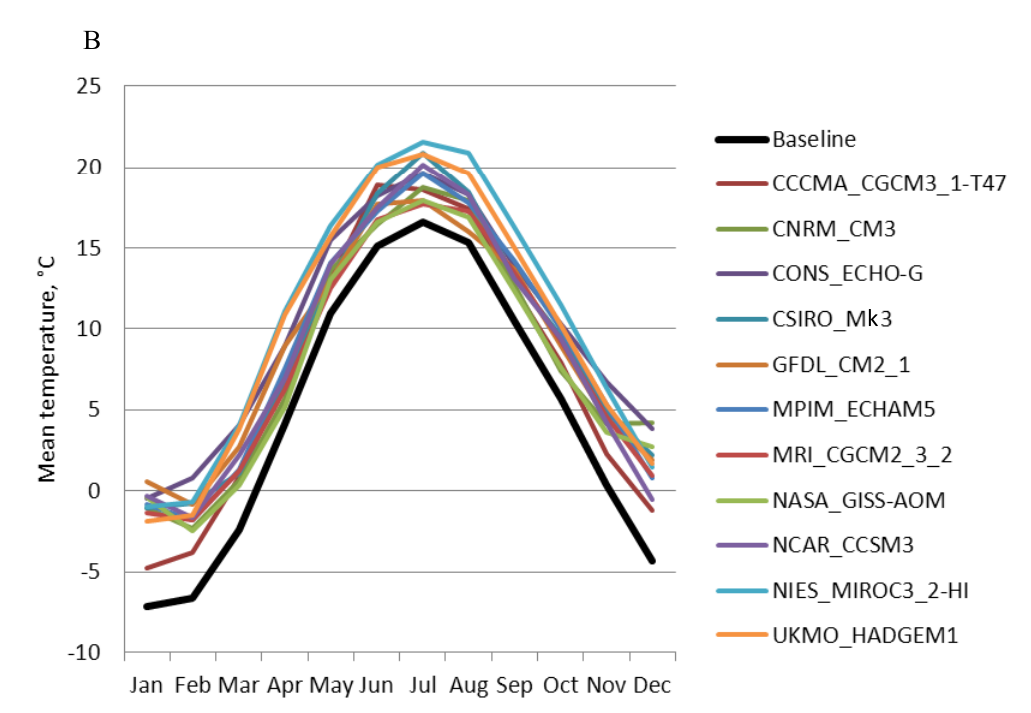
Fig. 5. Annual curve of monthly mean temperatures in western ( A ) and eastern ( B ) Estonia observed in 1961(cid:150)1990 (baseline) and modelled for 2070(cid:150)2099 using the A1B emission scenario and 12 GCM